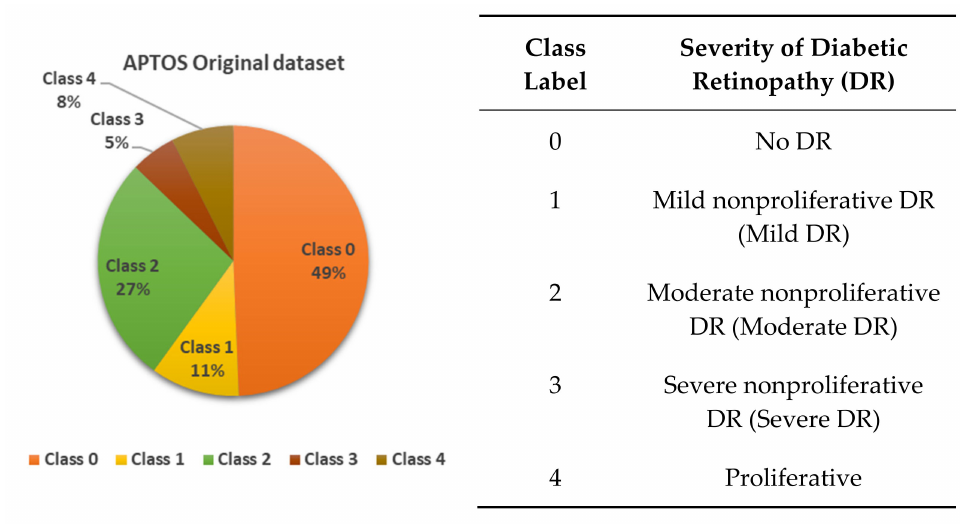
Figure 2. Original APTOS dataset.